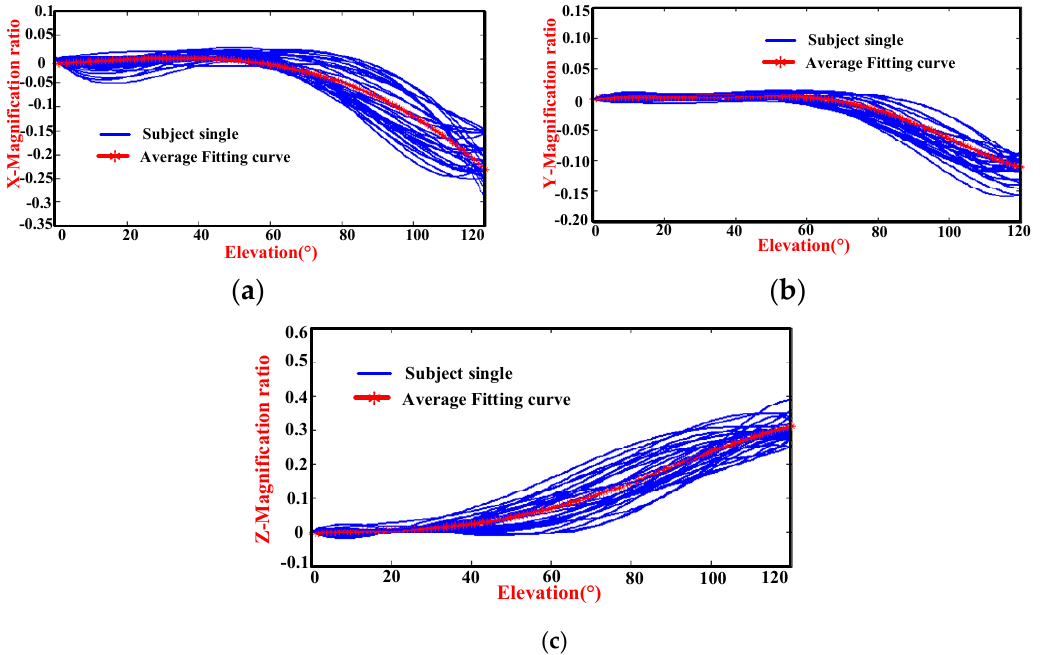
Figure 8. Diagrams of the magnification ratio of the GH joint center displacement variable quantity relative to the thorax coordinate system during humeral elevation in the sagittal plane: ( a ) X-magnification ratio and elevation angle, ( b ) Y-magnification ratio and elevation angle, and ( c ) Z-magnification ratio and elevation